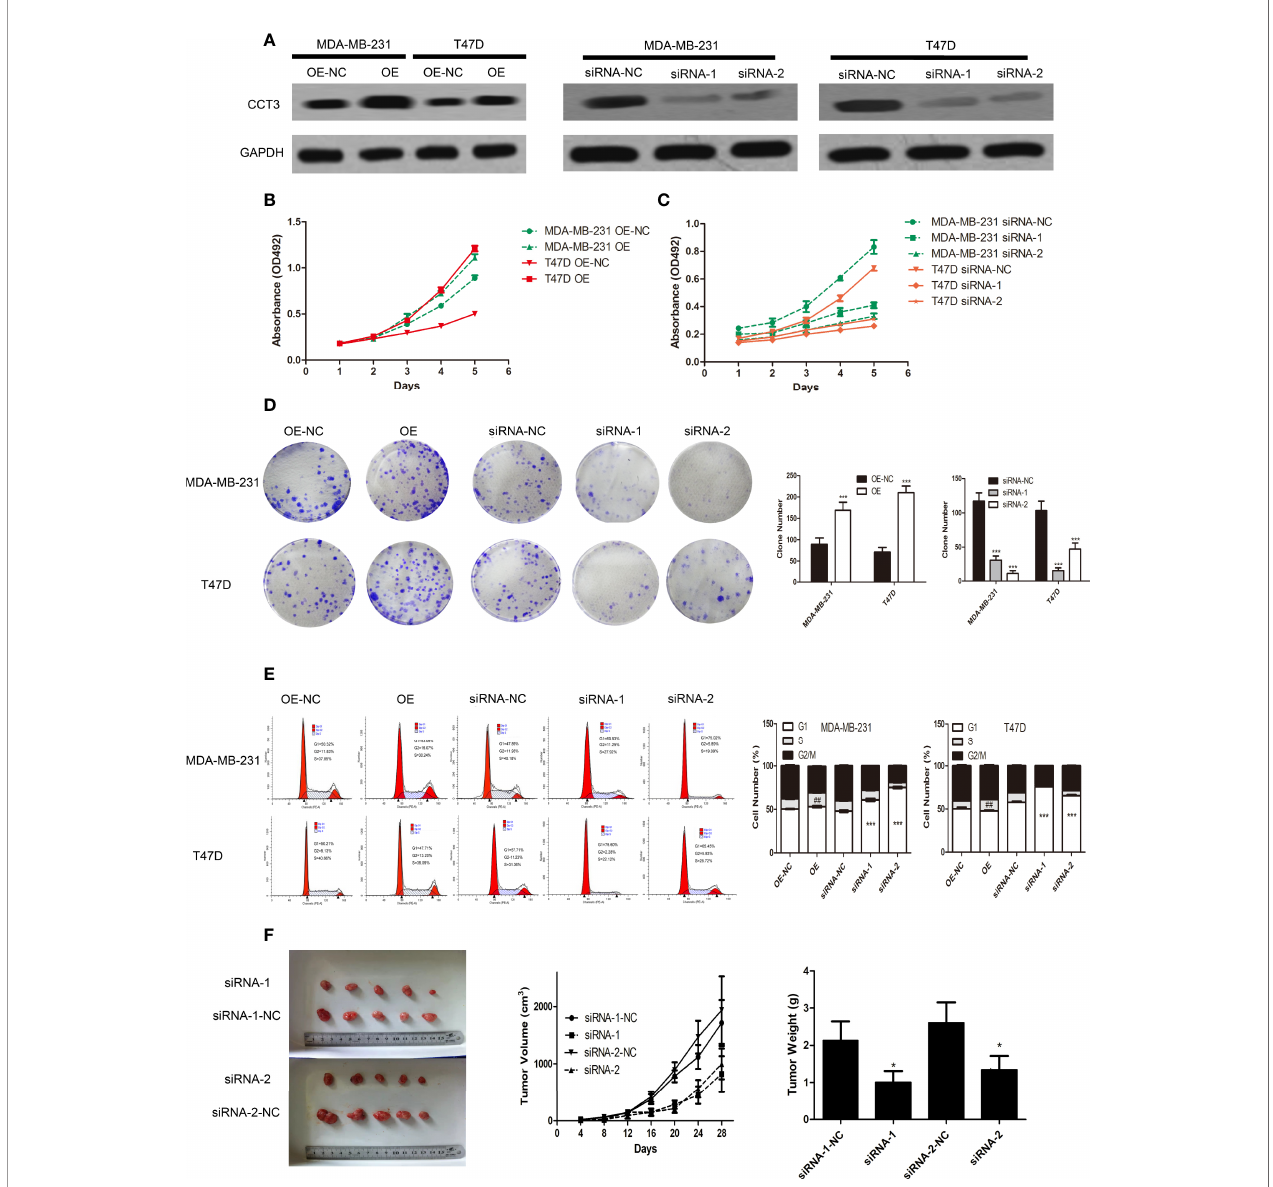
FIGURE 2 | CCT-3 promotes breast cancer cell proliferation and tumorigenicity in vitro and in vivo. (A) Protein levels of CCT-3 expression in CCT-3-overexpressed and CCT- 3-silenced cells. MTT assays (B, C) , colony formation assay (D) , and fl ow cytometric analysis (E) indicated that the growth rates increased in CCT-3-overexpressed cells and decreased in CCT-3-silenced cells. The cells were arrested in G2/M phase when CCT-3-silenced. Values are mean ± SD of three independent experiments. ##p < 0.01 (OE vs. OE-NC), ***p < 0.001 (siRNA vs. siRNA-NC), t-test. (F) Tumors derived from the vector-infected and the CCT-3-silenced cells. Representative images of tumor growth (left). Tumor volume growth curves (middle). Mean tumor weight (right) at 28 days after inoculation. *p < 0.05,